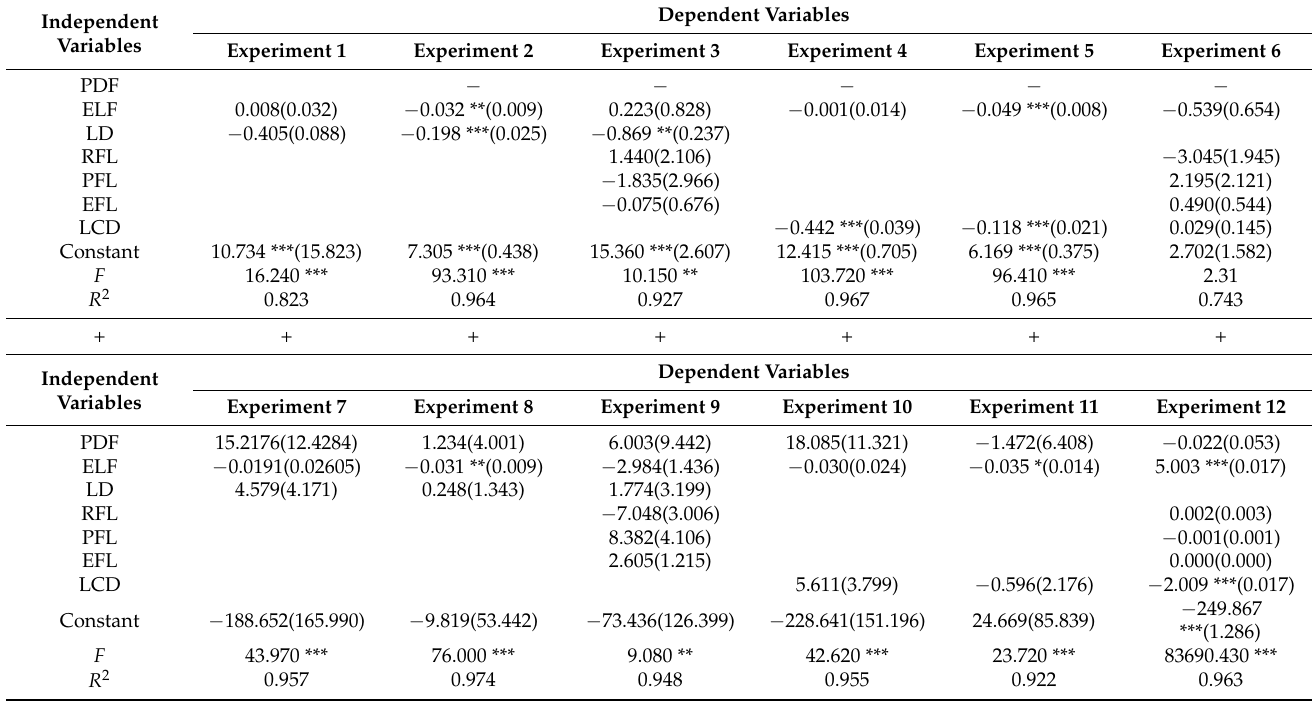
Table 9. Factors influencing supply in different experimental